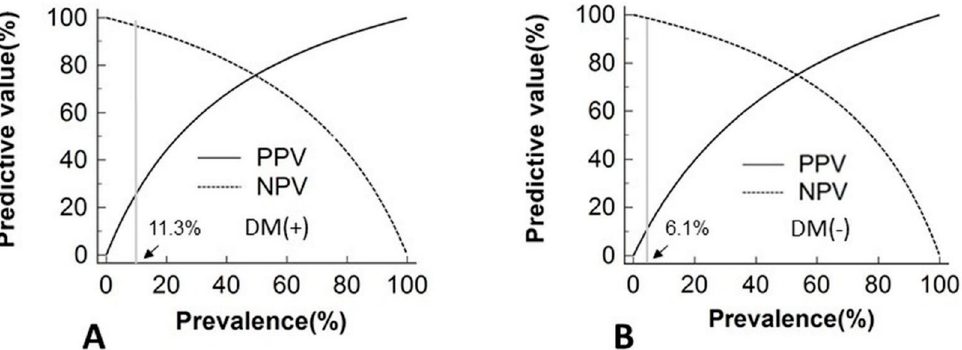
Figure 2. ARR to predict PA stratified by patients with or without DM. The GAM smoothing plot shows log odds to predict ( A ) PA ( B ) APA ( C ) IHA with spline Log (ARR) after multivariate adjustments. These GAM smoothing plots show a higher log-transformed ARR to predict PA in the patients with DM than those without DM in regard to log-transformed ARR < 2 (ARR < 100 ng/dL per ng/mL/h). Abbreviations: APA, aldosterone-producing adenoma; ARR, aldosterone to renin ratio; DM, diabetes mellitus; GAM, generalized additive model; IHA, idiopathic hyperaldosteronism; PA, primary aldosteronism.